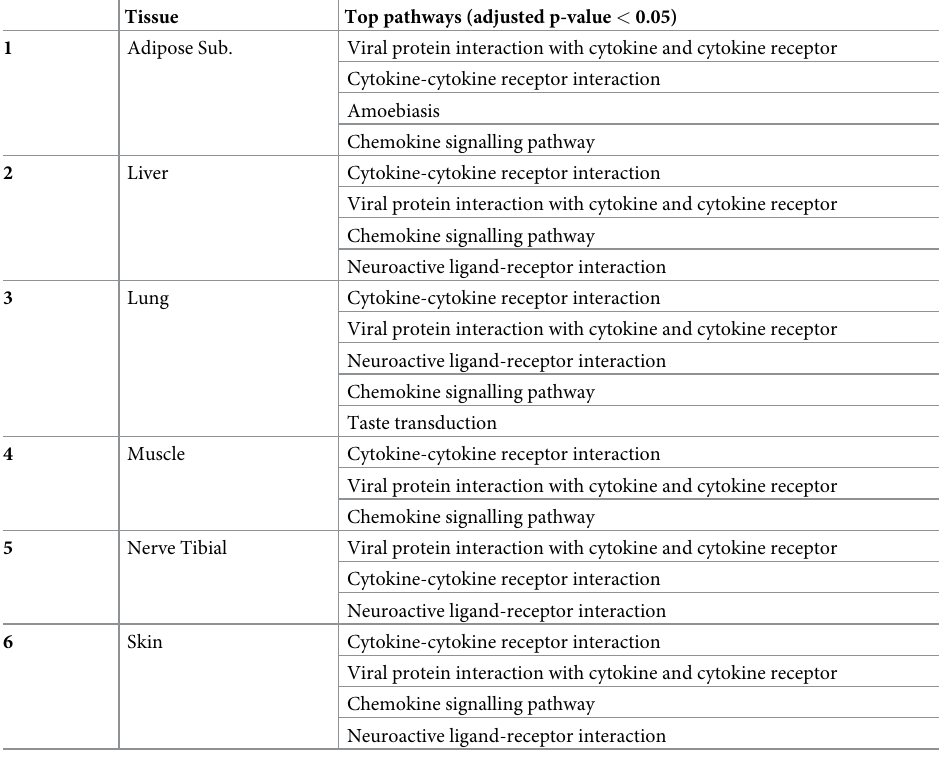
Table 5. Pathway enrichment analysis of the ventilation predictive marker genes across the six tested